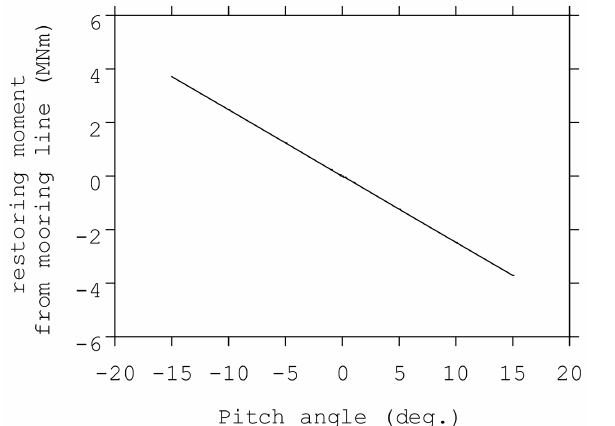
Figure 12. The relationship between the restoring pitch moment from mooring lines and pitch angle.